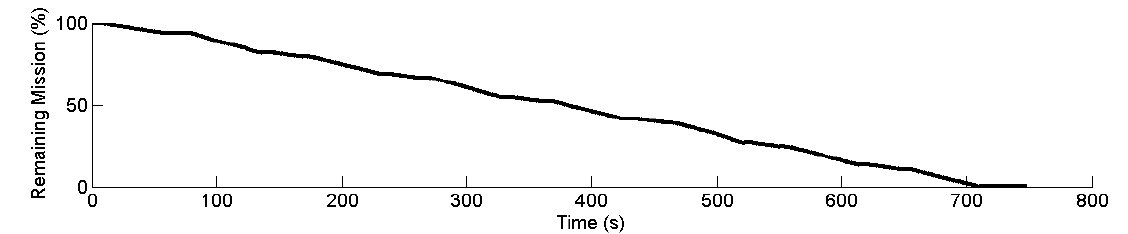
Figure 10. Remaining mission supervisor